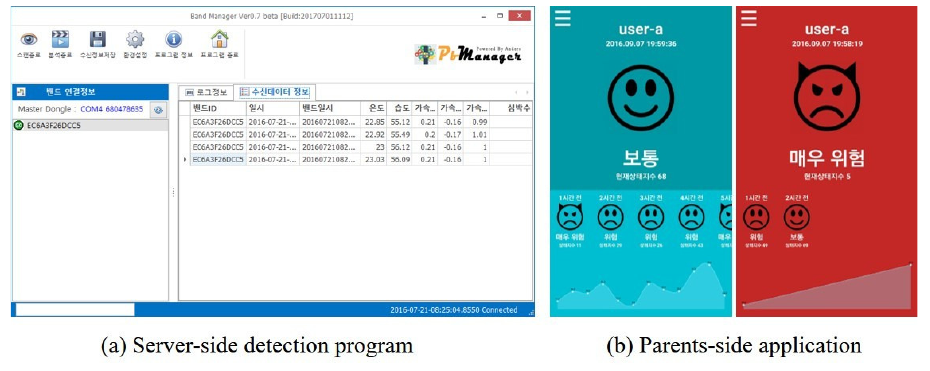
Figure 4. Prototype of ( a ) a stress detection program in server-side and ( b ) a monitoring application in parents-side.